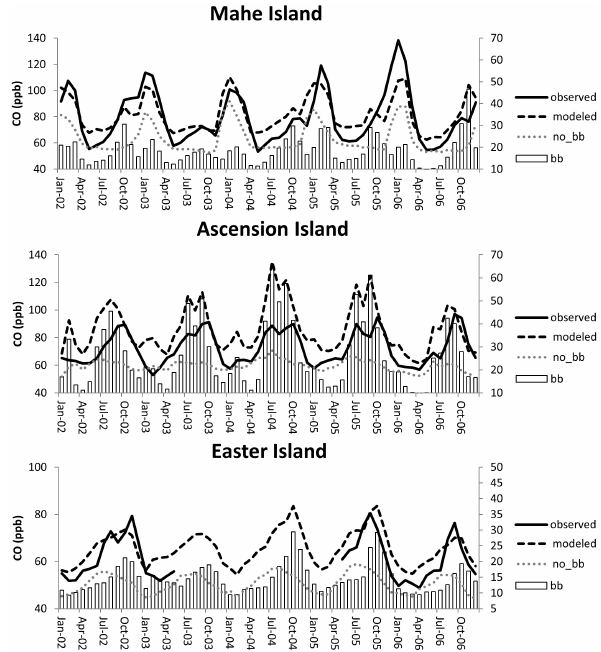
Figure 2. Variation of CO concentrations at the three stations in 2002–2006. “bb” means CO contributed by biomass burning, and “no_bb” means CO without contributed by biomass burning. The R.H.S. (right-hand side) scale only applies to the “bb”